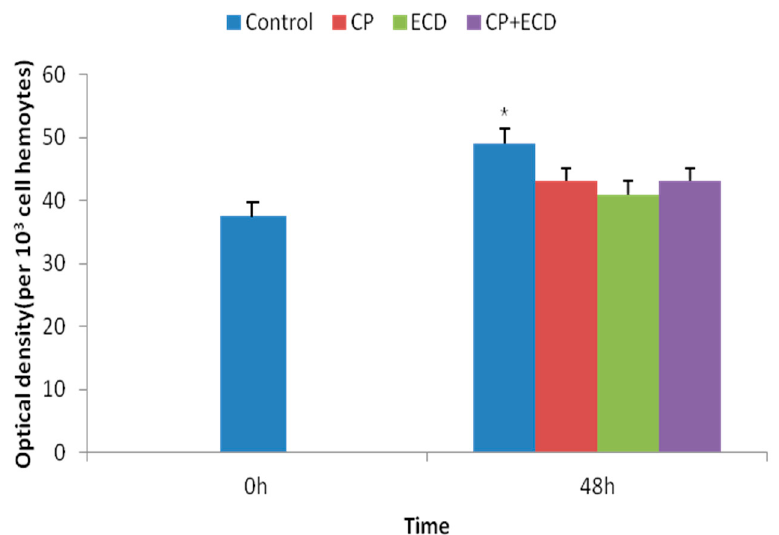
Figure 5. Effect of acute water-salinity stress for 48 h on respiratory burst activity in the abalone ( H. discus ) after feeding on the experimental diets supplemented with CP (6%), ECD (6%), and CP + ECD (3% + 3%) for 12 weeks. Vertical bars represent the SE of the means of three experiments. * p < 0.05 for control level at 48 h.